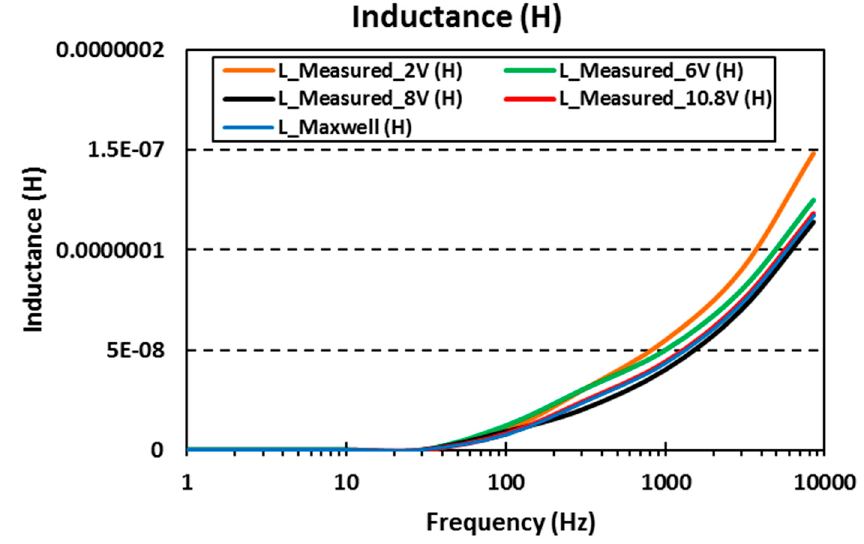
Figure 13. inductance as a function of the frequency for different initial voltage in the cells. Figure 13. Inductance as a function of the frequency for di ff erent initial voltage in the